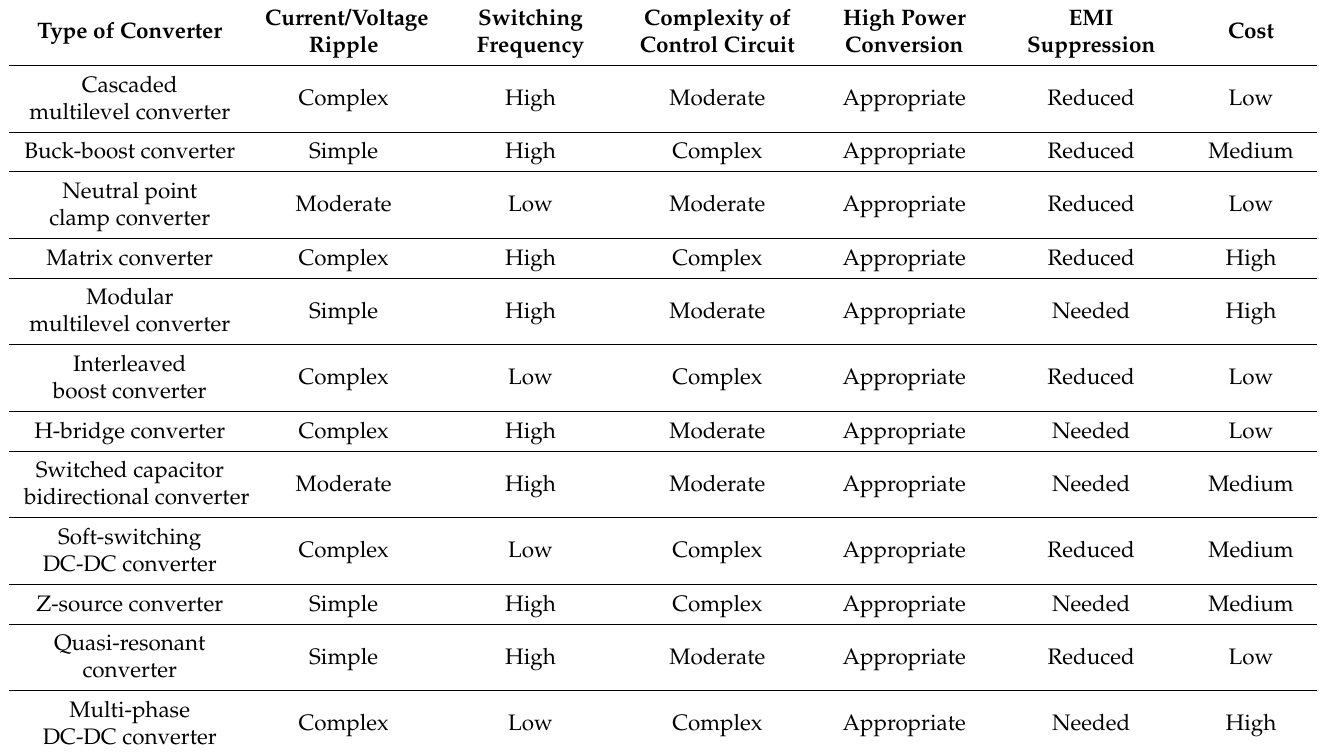
Table 6. Comparison of technical features of power electronics converters in EV